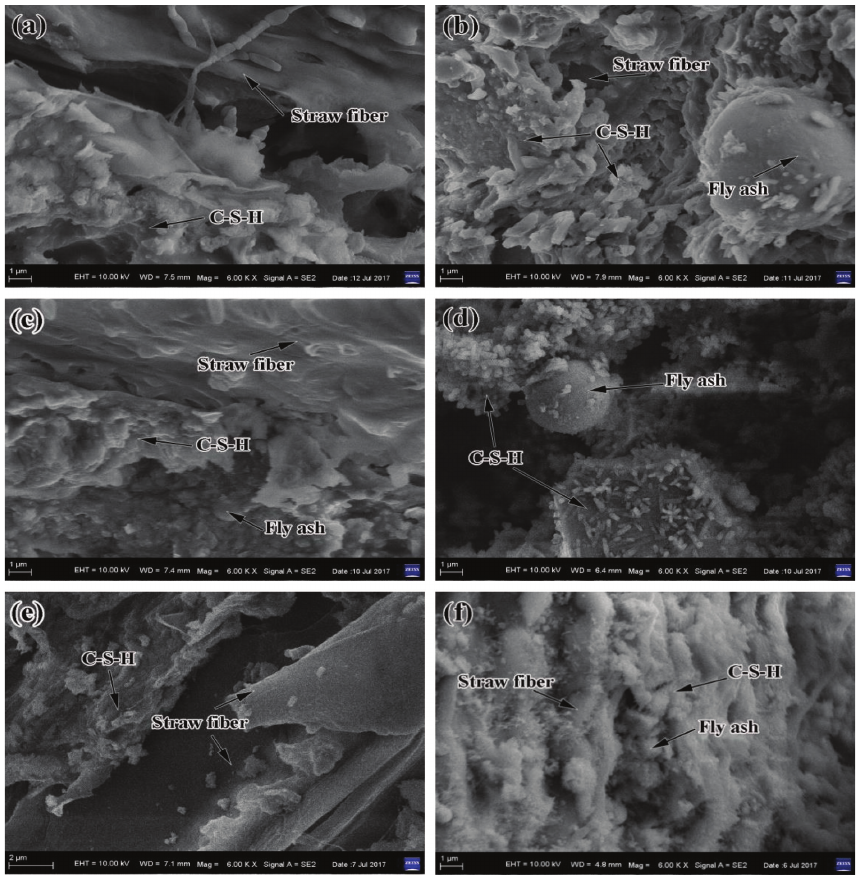
Figure 10: SEM images of SFCC (6000